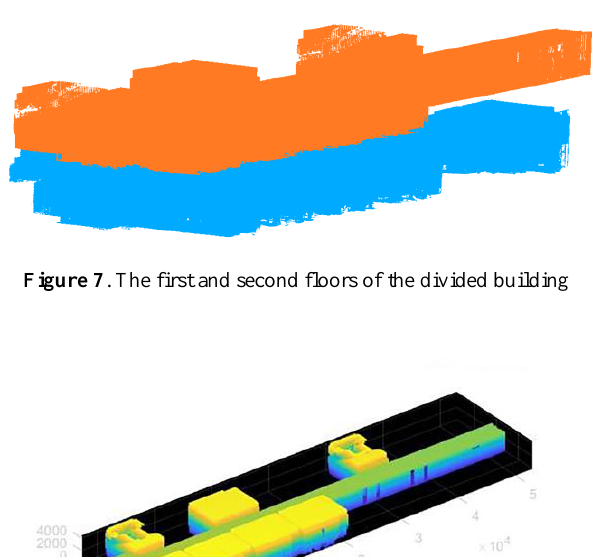
Figure 6 . Point cloud distribution density histogram